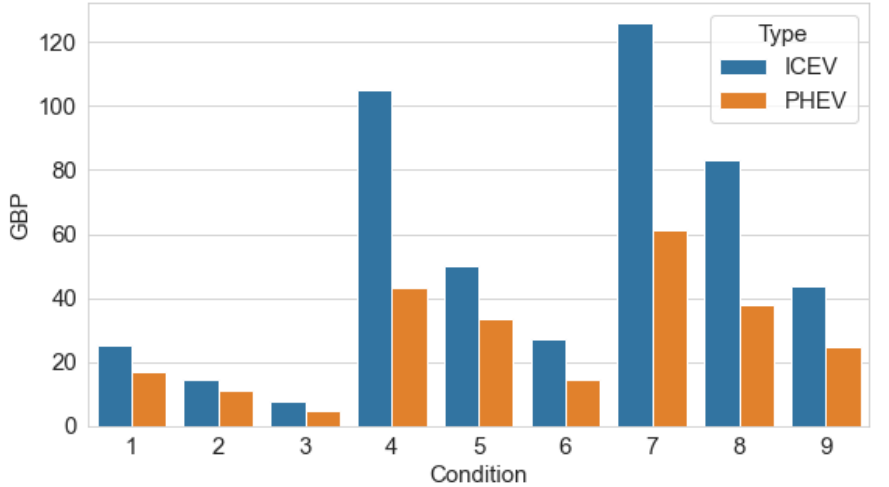
Figure 8. The total sum of petrol/electric costs (GBP) for each experiment condition across all vehicles. A core strength of ABMs over mathematical models, as specified earlier, is the spatio- temporal resolution variability of data. For instance, individual-level (vehicle-level) data are attained and should provide a more enhanced snapshot of the impact behaviour had on fuel